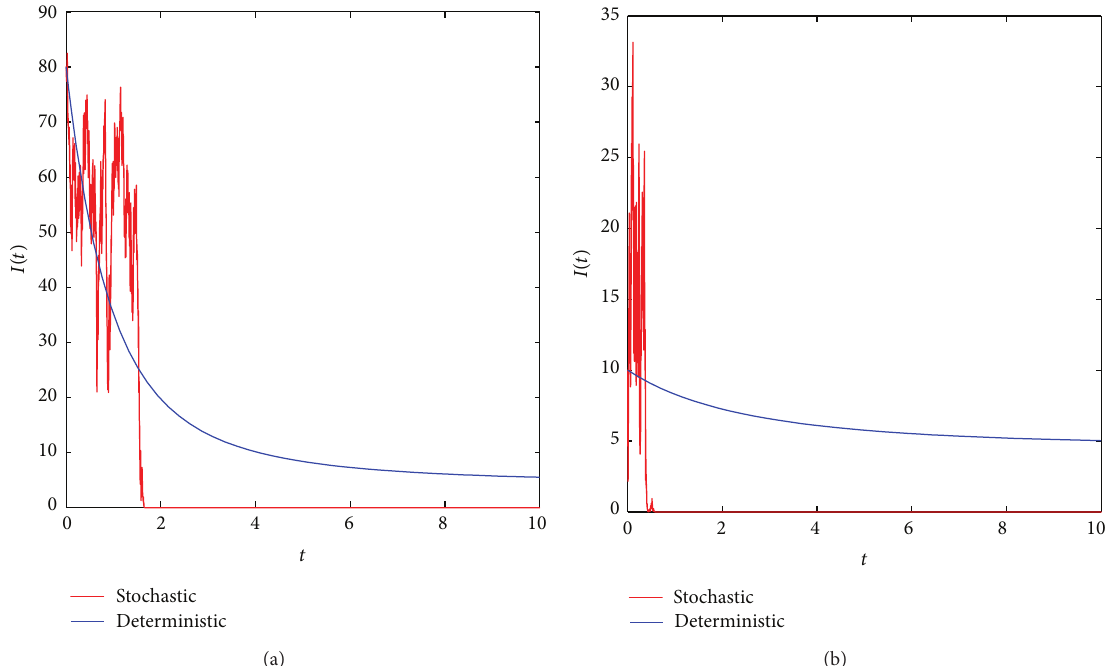
Figure 2: Computer simulations of 𝐼(𝑡) for model (5) and the deterministic model (1), using the EM method with step size 0.001 and with initial values (a) 𝐼(0) = 80 and (b) 𝐼(0) = 10